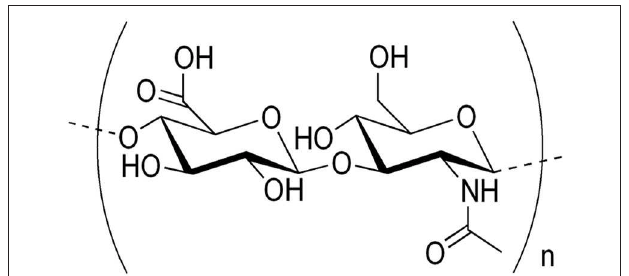
FIGURE 1 | Structural formula of hyaluronic acid